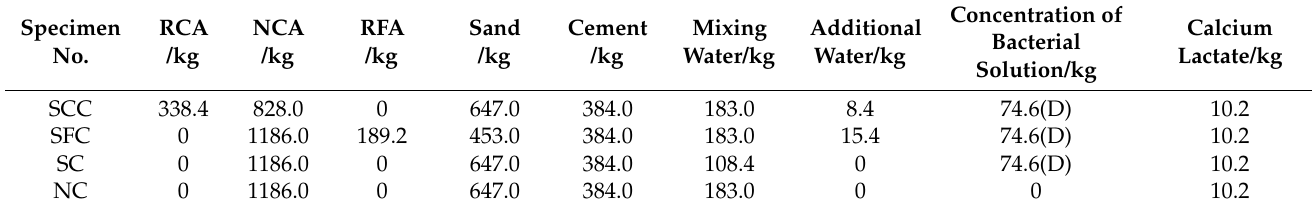
Table 4. Specimens’ mix ratio.